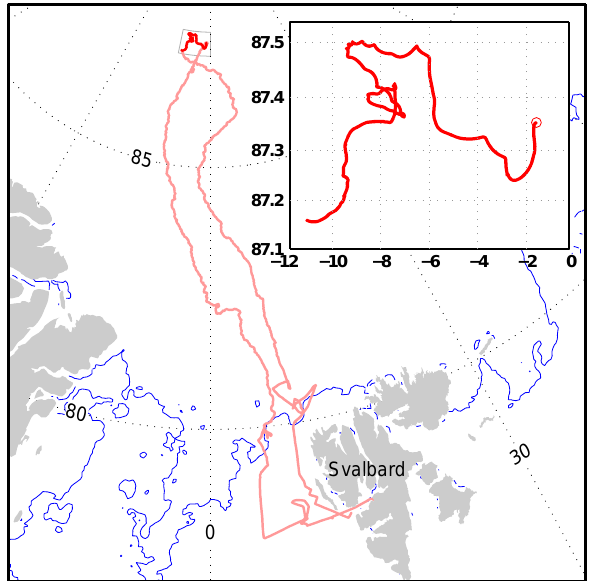
Fig. 1. The cruise route of Oden , enlarged is the time of the drift with the ice